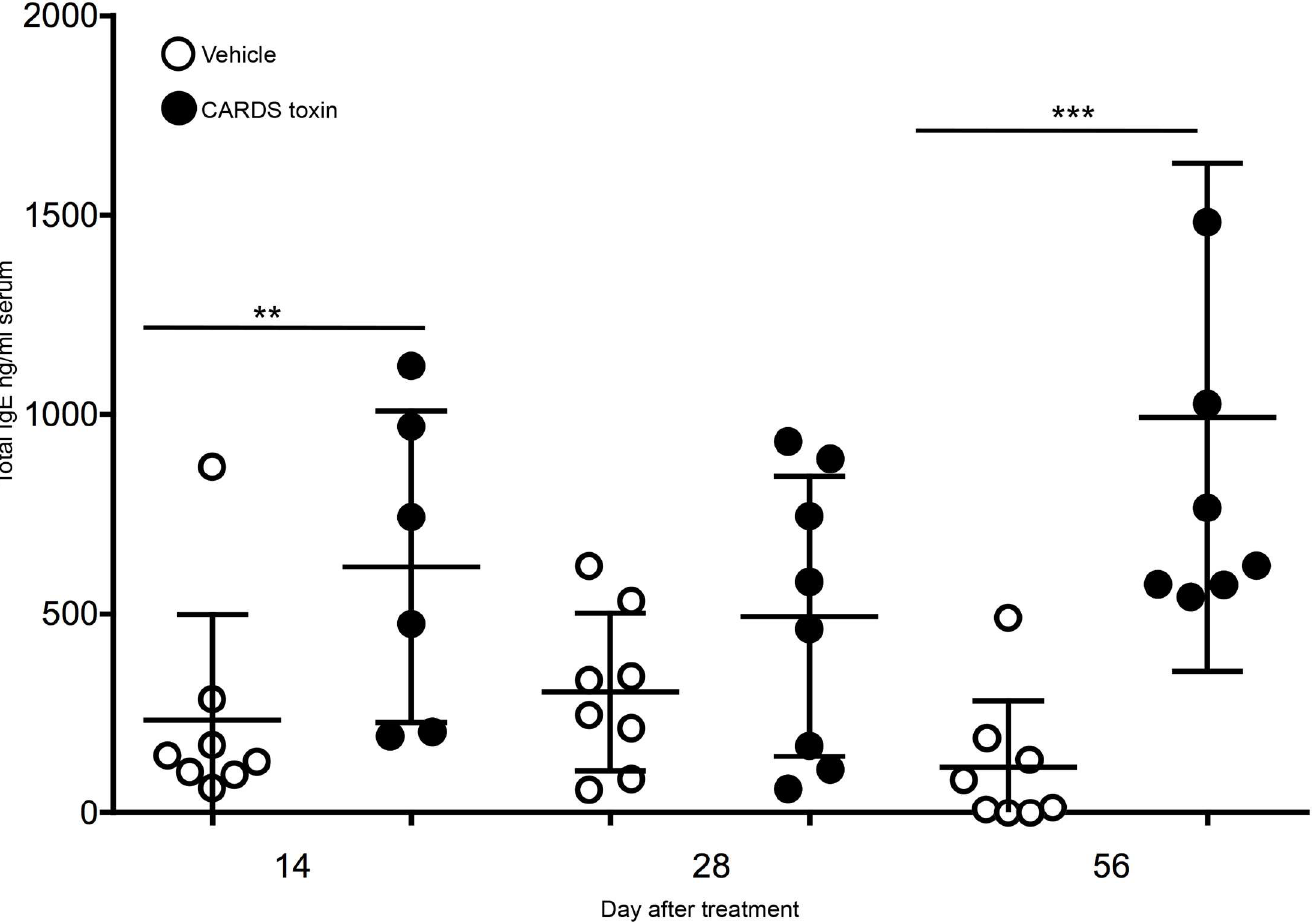
Fig 1. A single mucosal exposure leads to increased total serum IgE. Mice were treated IT with 700 pmol CARDS toxin or vehicleand then serum was collectedat the indicatedtime points. Serum was diluted 1:50 and the concentration of IgE determinedby ELISA. Data is presentedas the mean and standarddeviationof two independent experiments with each circle representinga mouse ( ** p < 0.005, *** p < 0.0005,N = 6–8 mice).